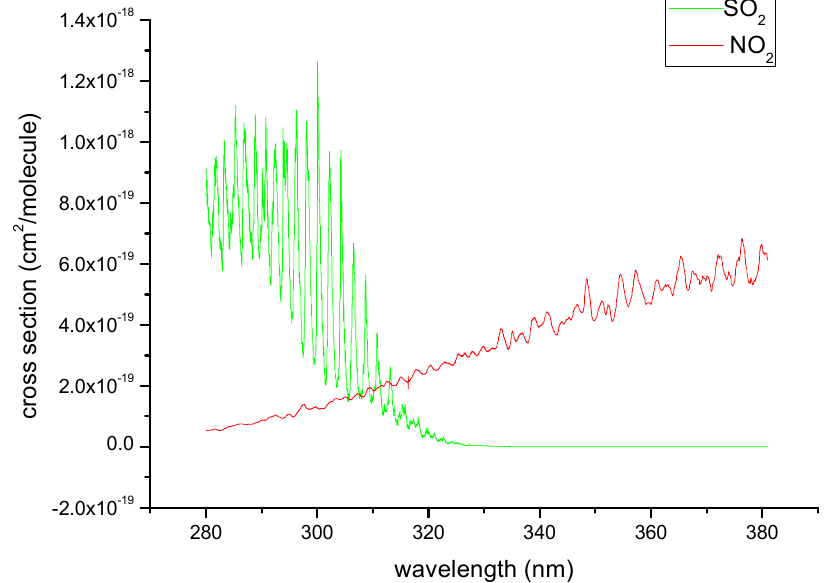
Figure 1. SO 2 absorption cross-section and NO 2 absorption cross-section (data source: The HITRAN 2016 molecular spectroscopic database [21]).